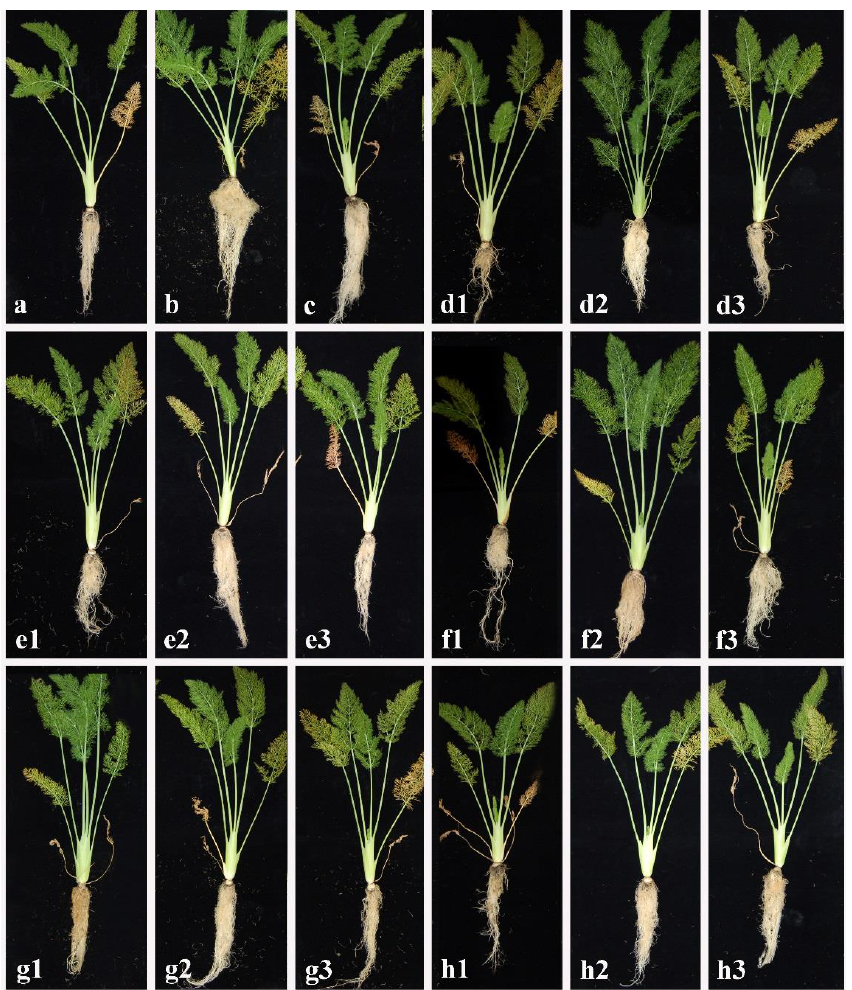
Figure 2. Effectiveness of CARA17 strain as antagonist for controlling disease severity by dipping treatment and after transplanting of fennel seedlings. Fennel seedlings not treated ( a ), treated with CARA17 strain by dipping ( b ) and after transplanting ( c ). Fennel seedlings treated by only fungal pathogen (1); fungal pathogen with CARA17 strain by dipping (2) and after transplanting (3). Inoculation with: Athelia rolfsii ( d1 – d3 ); Fusarium oxysporum ( e1 – e3 ); Plectosphaerella ramiseptata ( f1 – f3 ); Sclerotinia sclerotiorum ( g1 – g3 ); Verticillium dahliae ( h1 – h3 ).